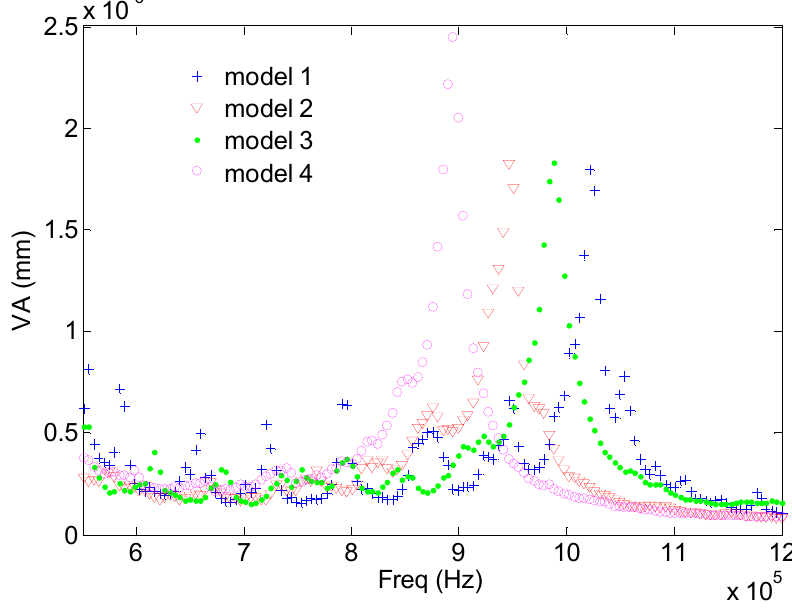
Figure 6. Average of the maximum value of the vibration along the z axis of all the calculated points in the aluminum face (VA) as a function of the vibration frequency.